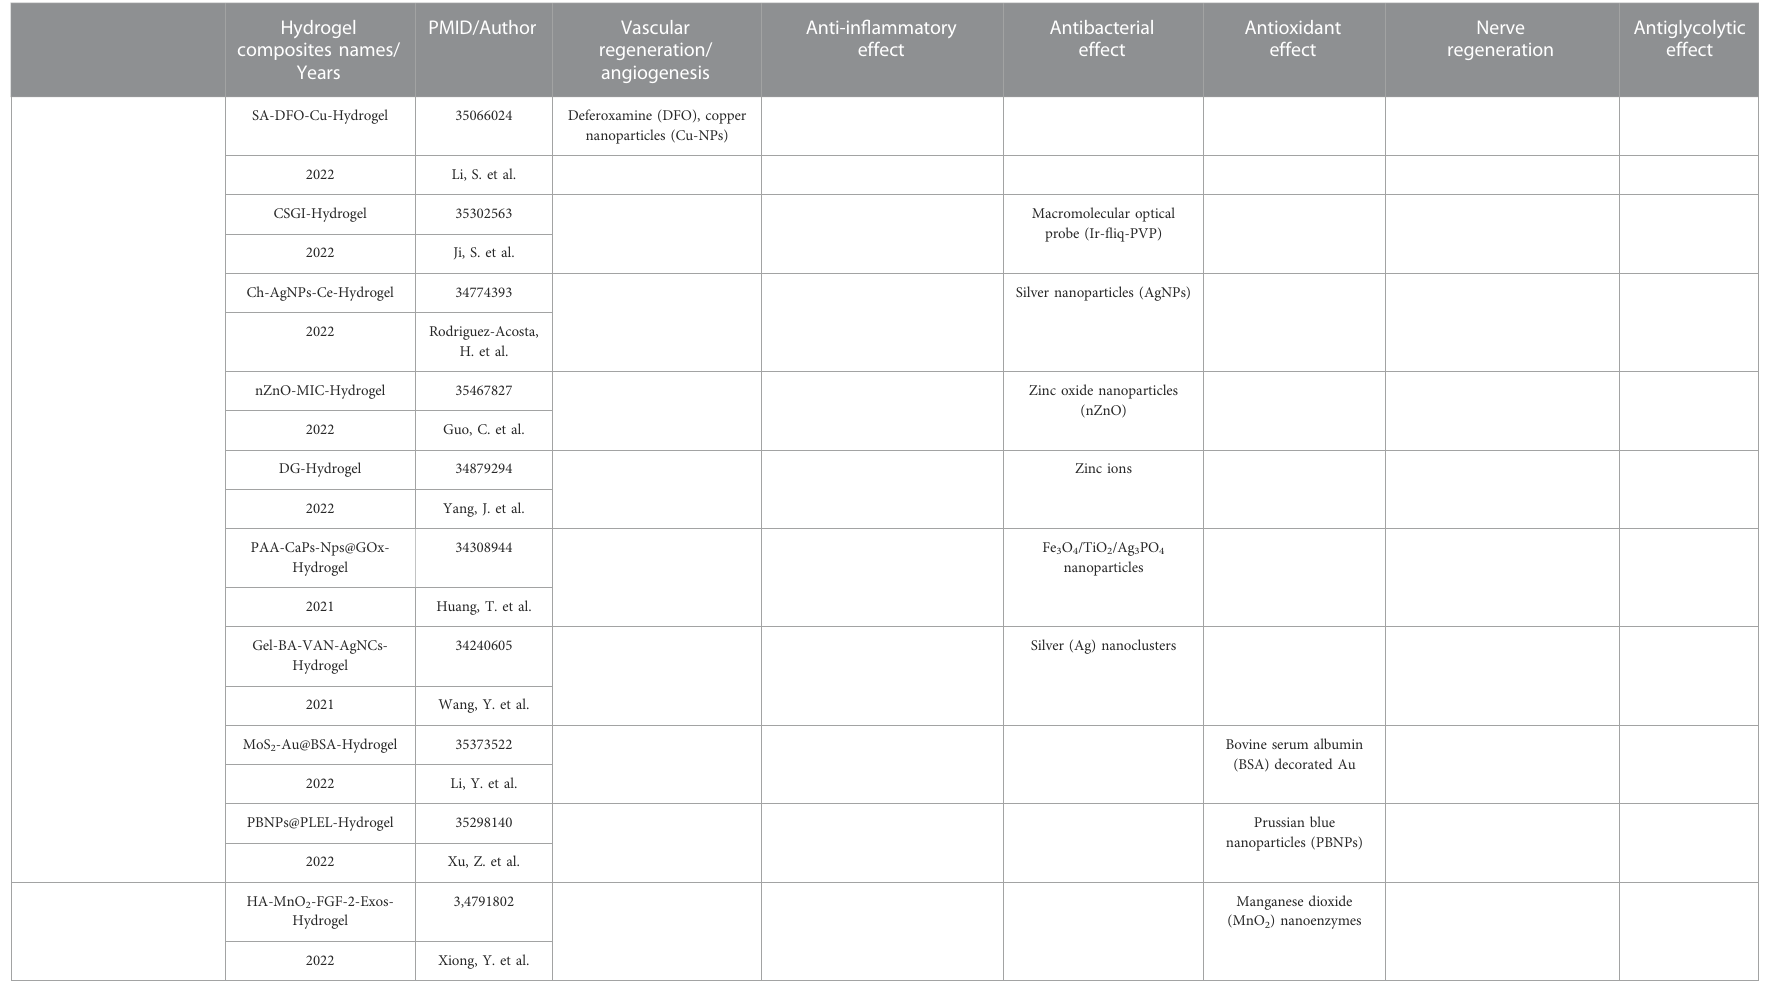
TABLE 1 ( Continued ) Classi fi cation of loading components in composite hydrogels in the treatment of chronic diabetic